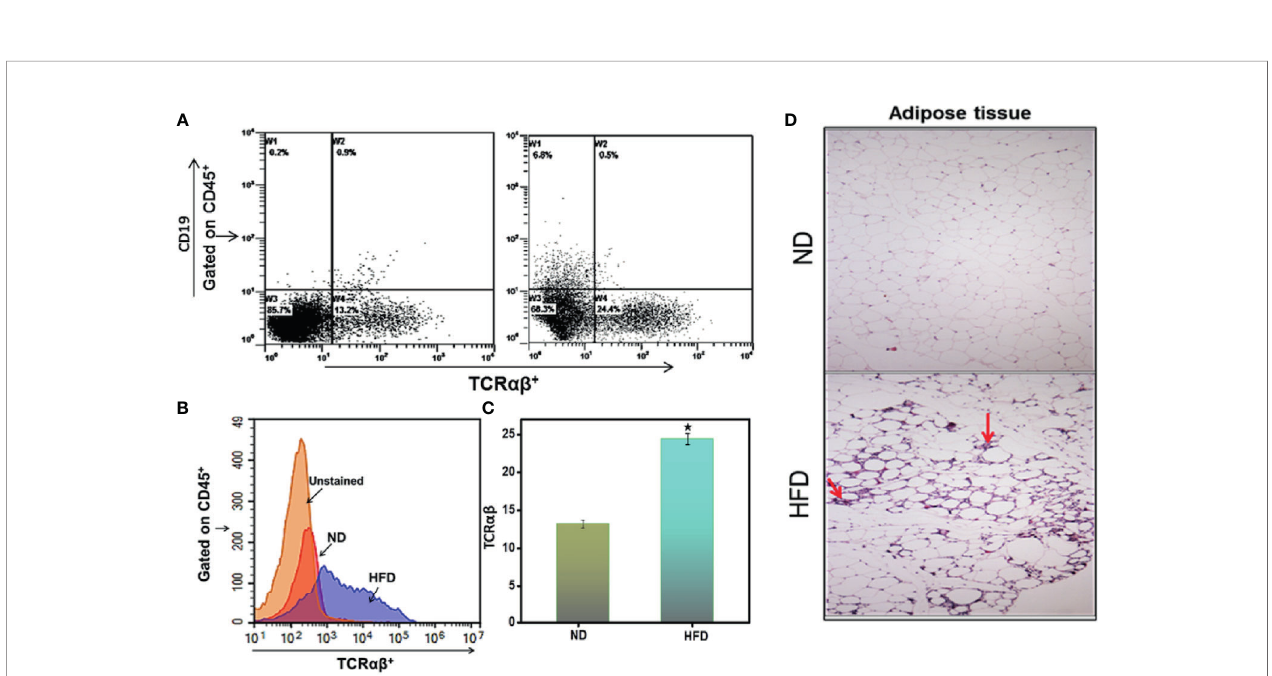
FIGURE 2 | DIO induces immune cell in fi ltration in the adipose tissue. Peripheral AT was isolated from the two groups of mice (HFD and ND) after 16 weeks and stained for CD45 + , CD19, and TCR ab + Abs. (A) Shows a representative experiment indicating the percentages of TCR ab + in the cells gated on CD45 + in peripheral fat adipose tissue. (B) Shows a representative overlay histogram of TCR ab + . (C) Shows cumulative data represent the total percentage of cells ± SEM; total n = 18 (six mice per group) from three independent experiments. The statistical signi fi cance between ND and HFD is assessed by Student ’ s t-test. *p < 0.05 indicate statistically signi fi cant differences in TCR ab + between ND and those fed HFD. (D) Shows adipose tissue was isolated and fi xed in 4% paraformaldehyde, embedded in paraf fi n, and sectioned at 6 m m. Sections were stained with hematoxylin and eosin. Sections were examined microscopically at a magni fi cation of 10X by a